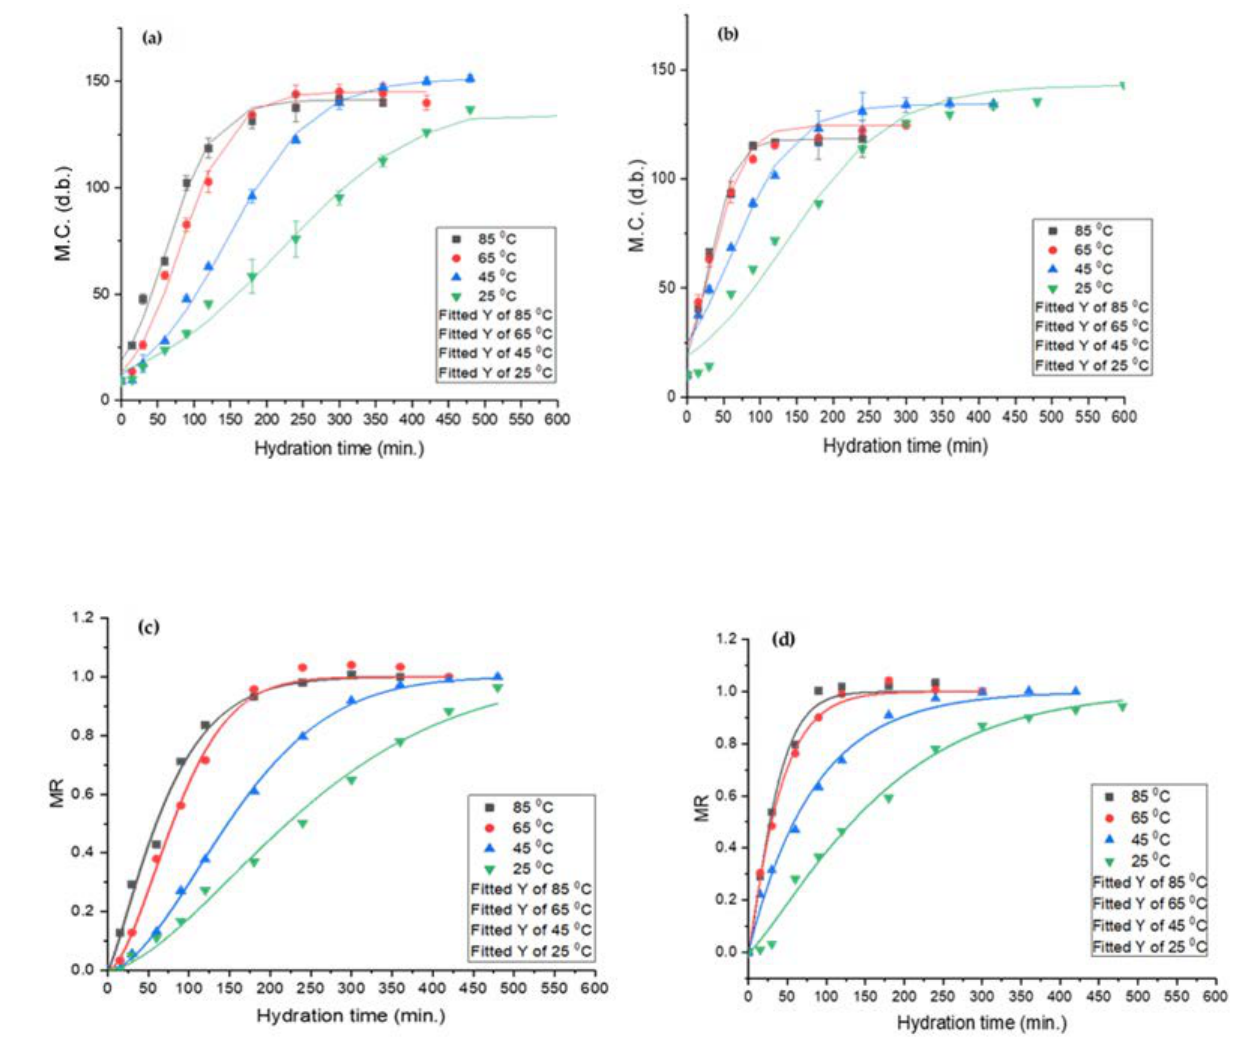
Figure 3. Sigmoidal model (top) and Weibull distribution model (bottom) for L. albus ( a , c ) and L. angustifolius ( b , d